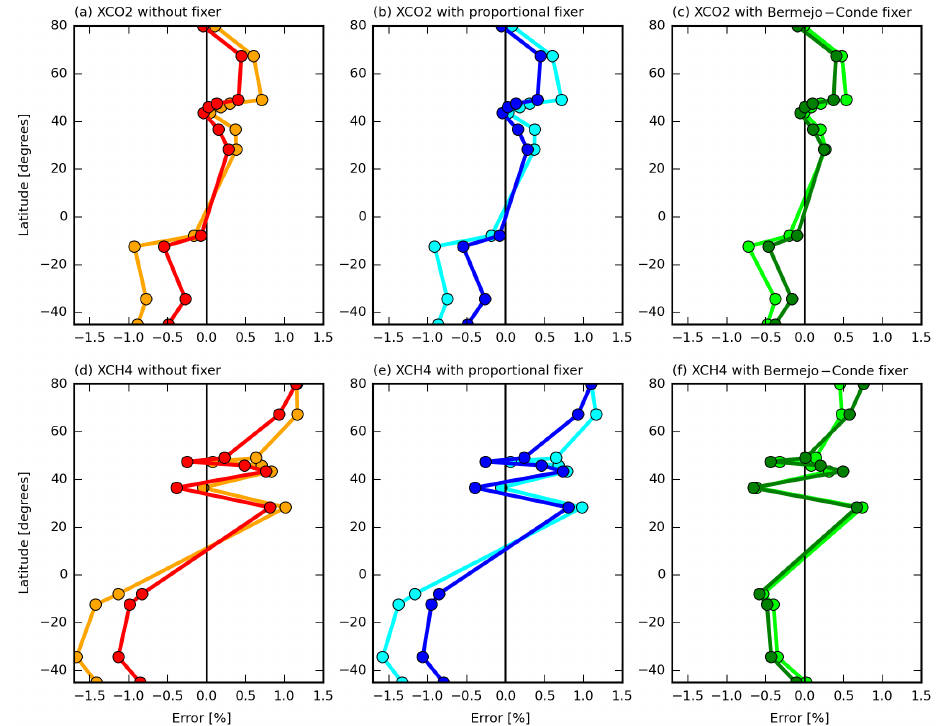
Figure 10. Error (%) of modelled latitudinal monthly mean (7 March to 10 April) distribution computed as (MODEL − OBS)/OBS using different tracer mass fixers and different resolutions for (a–c) XCO 2 and (d–f) XCH 4 with respect to the observed distribution from TCCON. Dark and light colours correspond to the simulations at low and high resolution respectively.